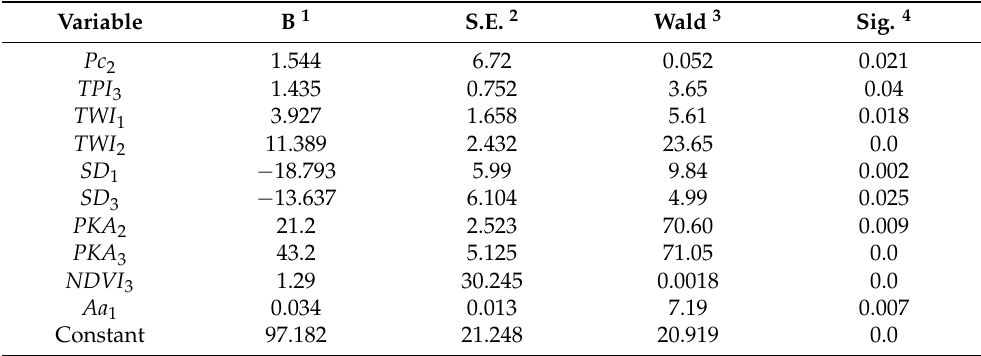
Table 4. Results of logistic regression method.